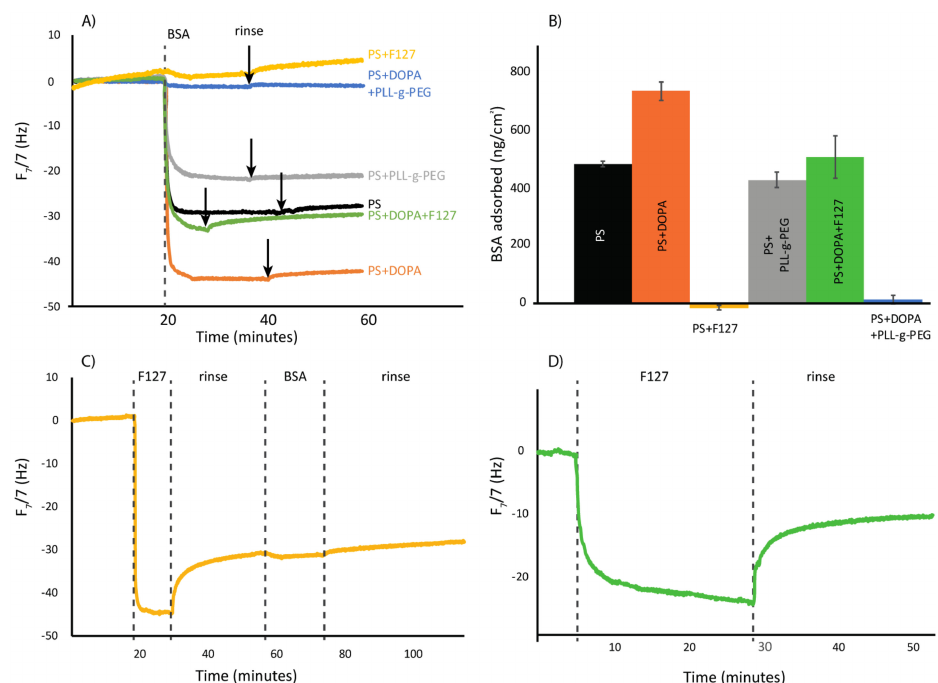
Figure 1. ( A ) Example QCM-D frequency data comparing BSA (bovine serum albumin) adsorption to the different surface chemistries investigated, namely untreated polystyrene (PS) and polystyrene treated with Pluronic F127 (PS + F127), polydopamine (PS + DOPA), PLL- g -PEG (PS + PLL- g -PEG) or PS + DOPA additionally treated with PLL- g -PEG (PS+DOPA + PLL- g -PEG) or Pluronic F127 (PS + DOPA + F127). All data has been shifted in time to start the BSA adsorption at the same time. Start of rinsing with buffer is indicated in the graph with arrows for each curve. ( B ) Average adsorbed BSA to the different surface chemistries (error bars represent standard deviation); ( C ) QCM-D frequency graph showing deposition of F127 Pluronic onto a PS coated QCM-D crystal with subsequent rinse-off and BSA adsorption step; ( D ) F127 Pluronic adsorption onto polydopamine coated PS coated crystal showing a lower adsorption of F127 compared to bare